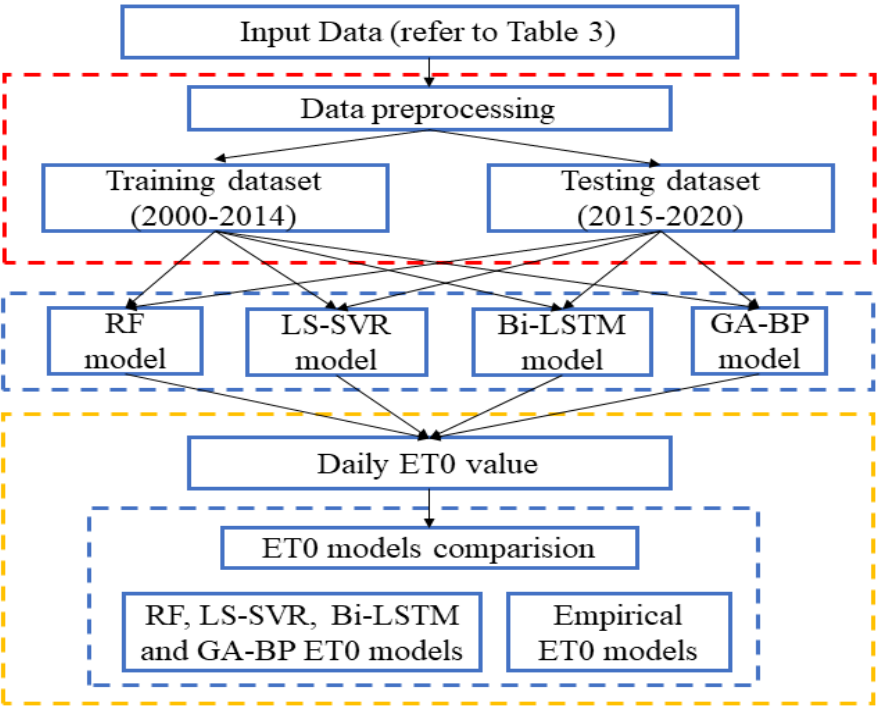
ET 0 model study